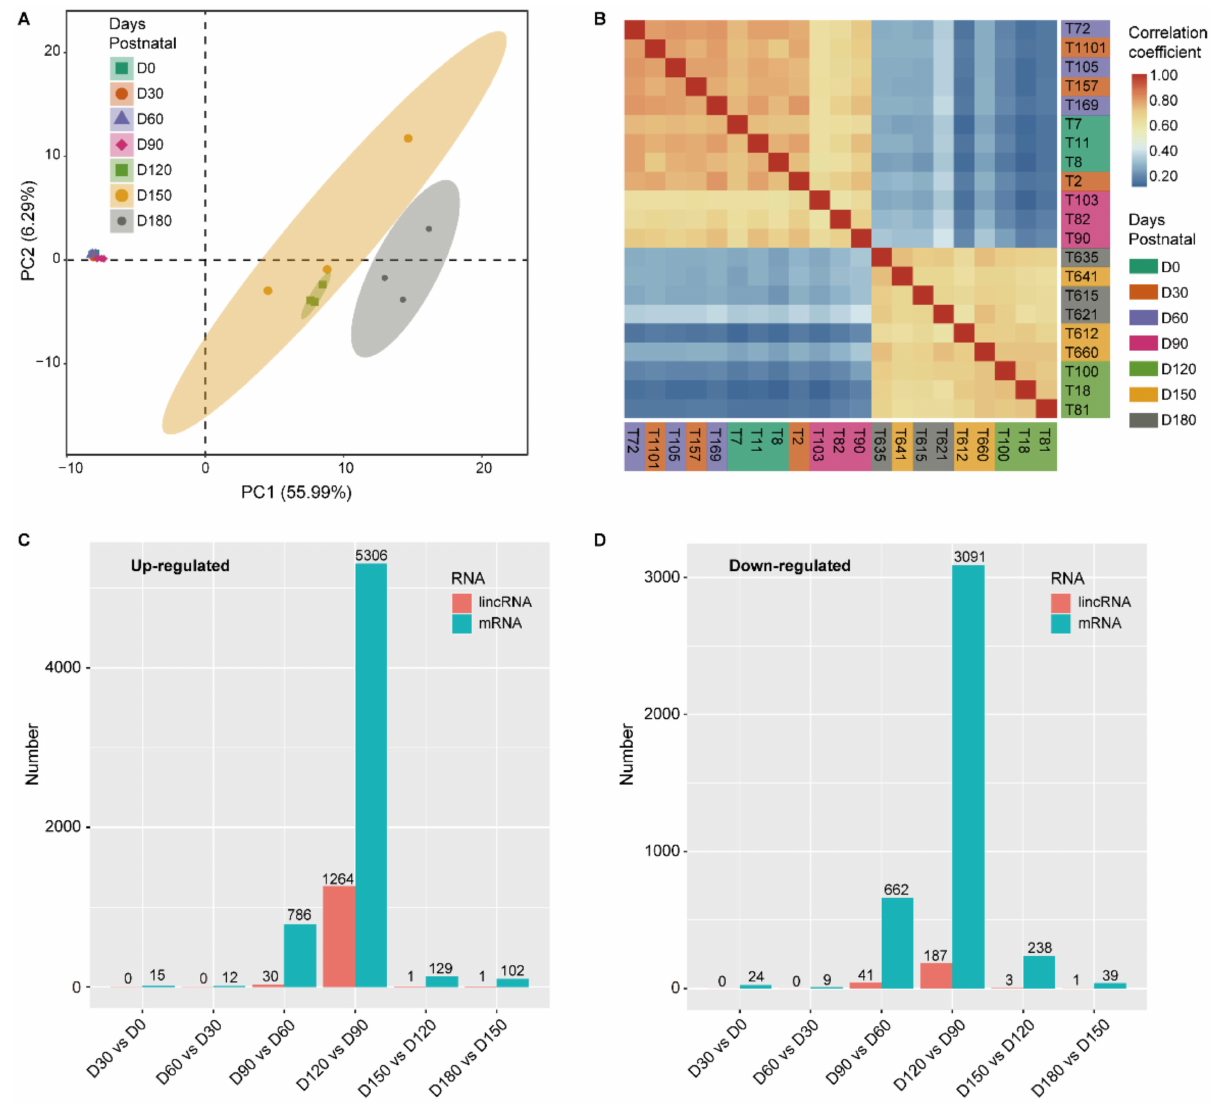
Figure 2. The discrete expression patterns of lincRNAs and mRNAs. ( A ) Principal component analysis (PCA) of 21-pair distinct samples across the seven ages based on normalized lincRNA expression levels. The samples were clustered by age. ( B ) Heatmap of correlation coefficient for 21 samples based on the lincRNA expression level. The samples were grouped by hierarchical clustering and the dendrogram was not shown. The color of the blocks below the sample names represents the age group to which each of the samples belonged. ( C , D ) Number of differentially expressed lincRNAs and mRNAs between neighboring age